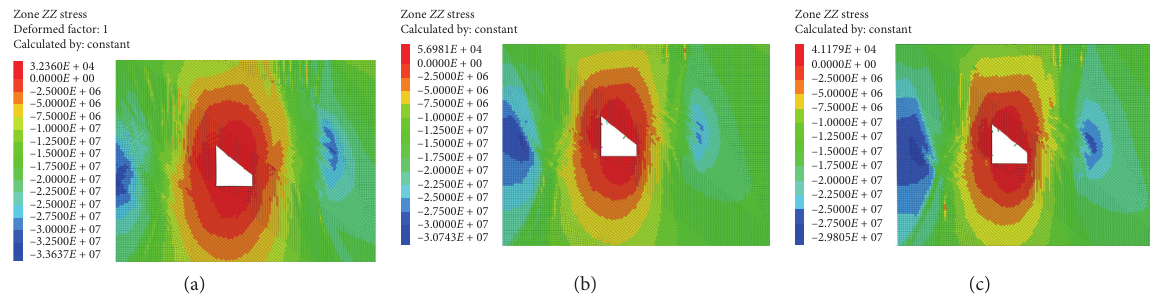
Figure 6: Vertical stress distribution of roadway under different support conditions. (a) No support state. (b) Supporting state of nontruss anchor cable. (c) Support state of truss anchor